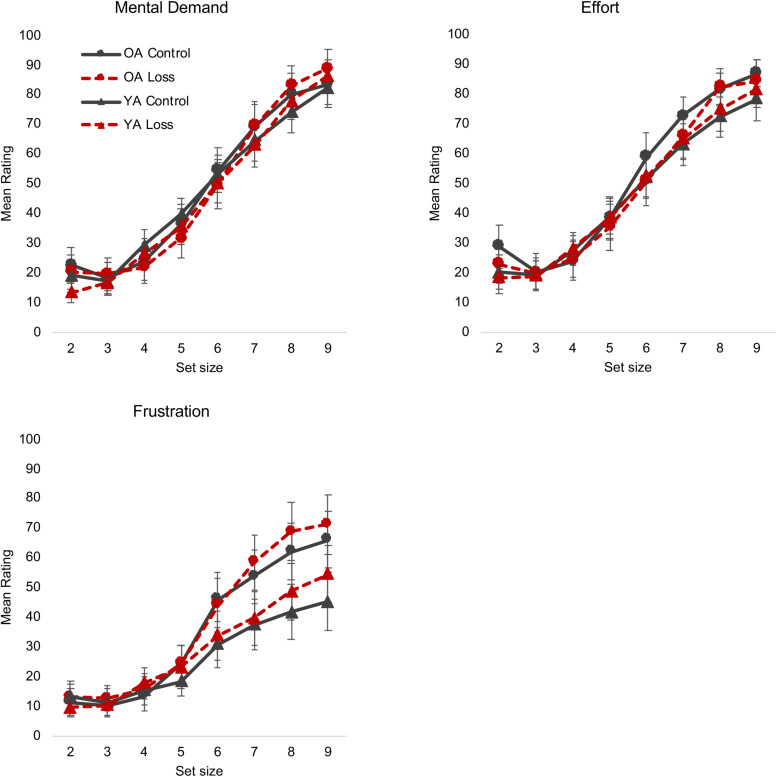
NASA-TLX mental demand, and effort, and frustration. Different colors/lines (control = black solid line, loss = red dashed line) and shapes [triangle = young adults (YA), circle = older adults (OA)] are used to highlight the different conditions. Error bars represent 95% confidence intervals. The loss incentive increased participants’ reports of mental demand and frustration but did not increase effort to meet those demands. NASA-TLX, NASA Task Load Index.